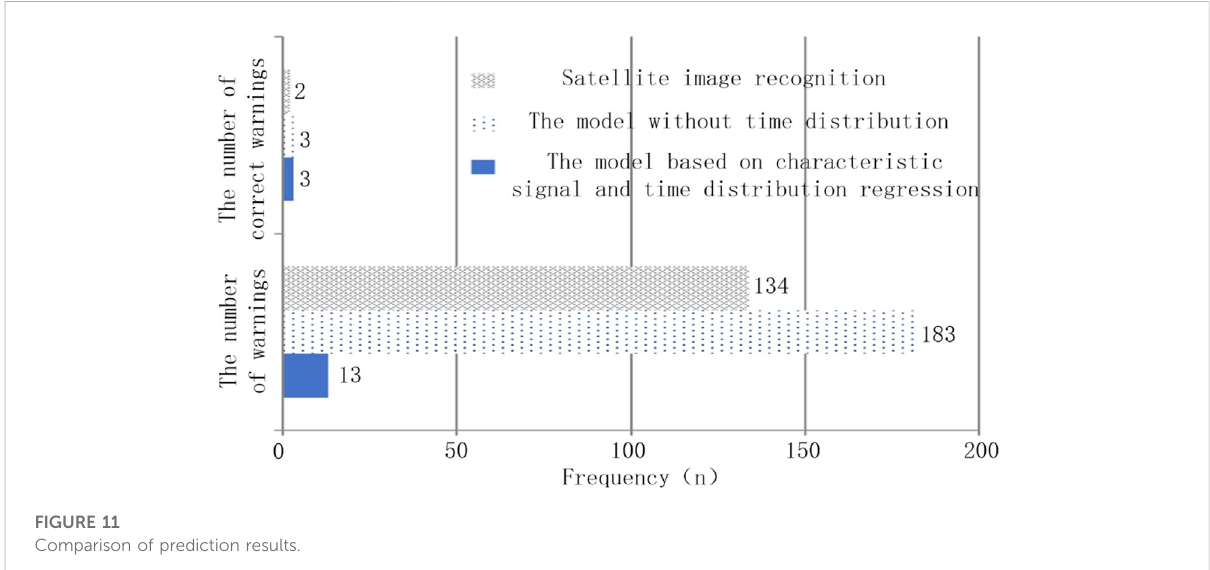
FIGURE 11 Comparison of prediction results.